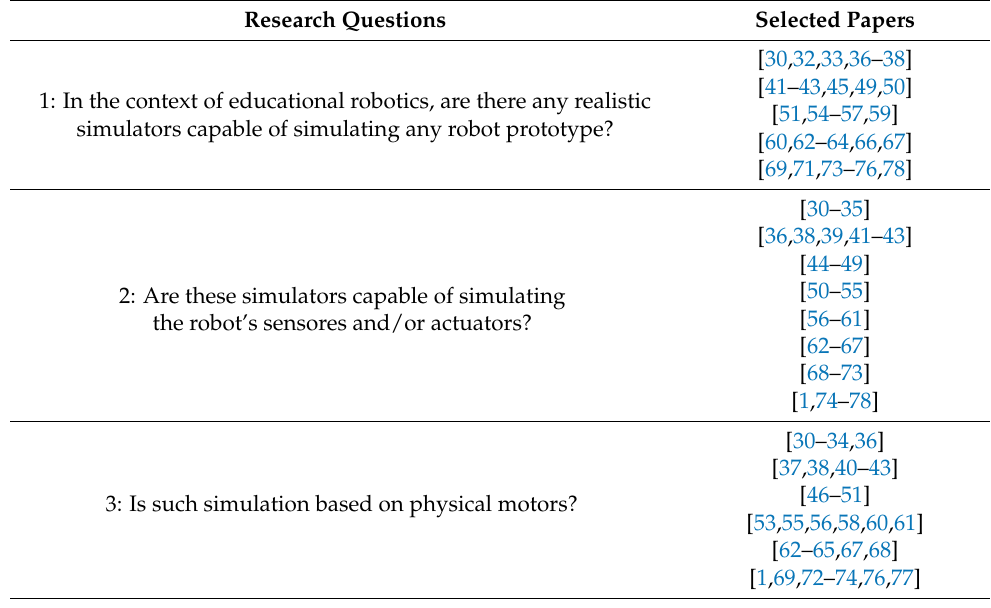
Table 7. Selected papers that address the Research